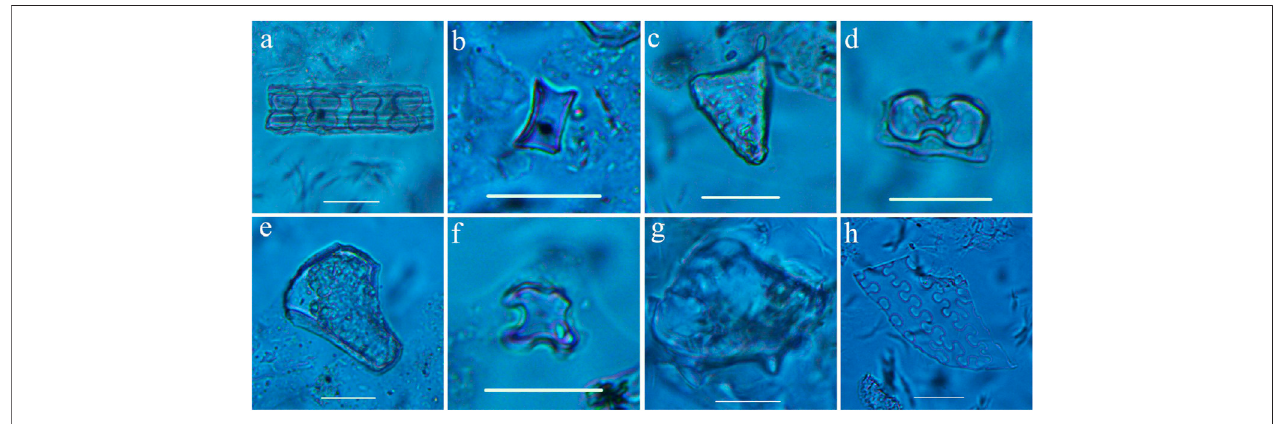
FIGURE 7 | Phytoliths from the Qingtai site (scale bar: 20 μ m). (A) : dumbbell with scooped ends paralleled arrangement; (B) : square saddle; (C) : hair cell; (D) : bilobate; (E) : fan-shape; (F) : cross; (G) : double-peak; (H) : Ω -type.